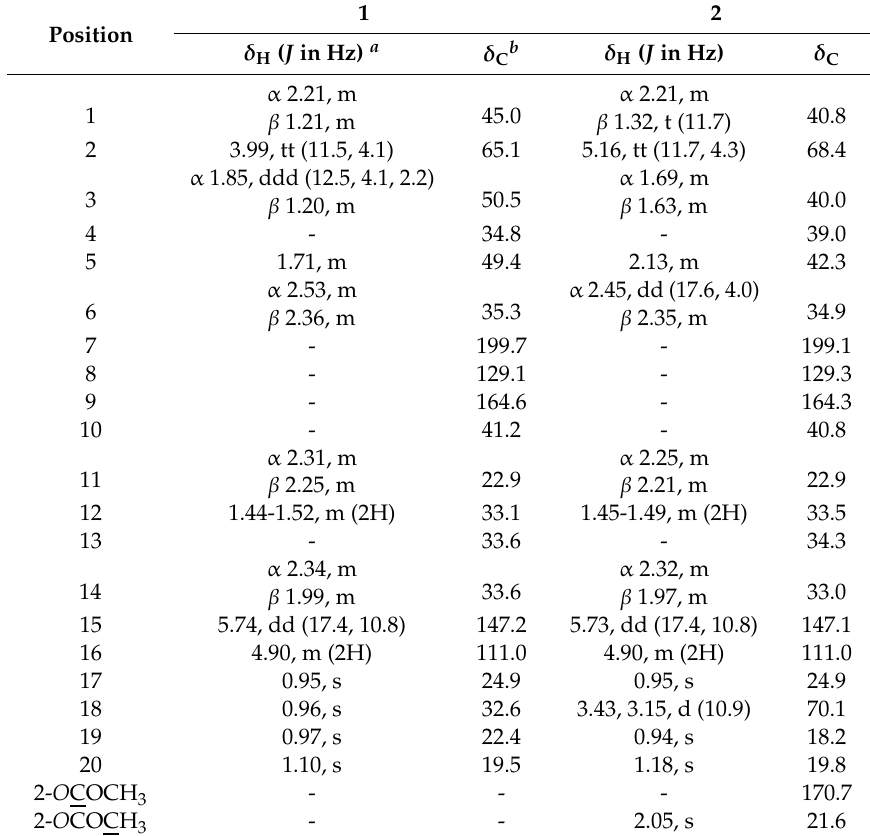
Table 1. 1 H- and 13 C-NMR Spectroscopic Data (CDCl 3 ) for Compounds 1 and 2 ( δ H in ppm, J in Hz). Position